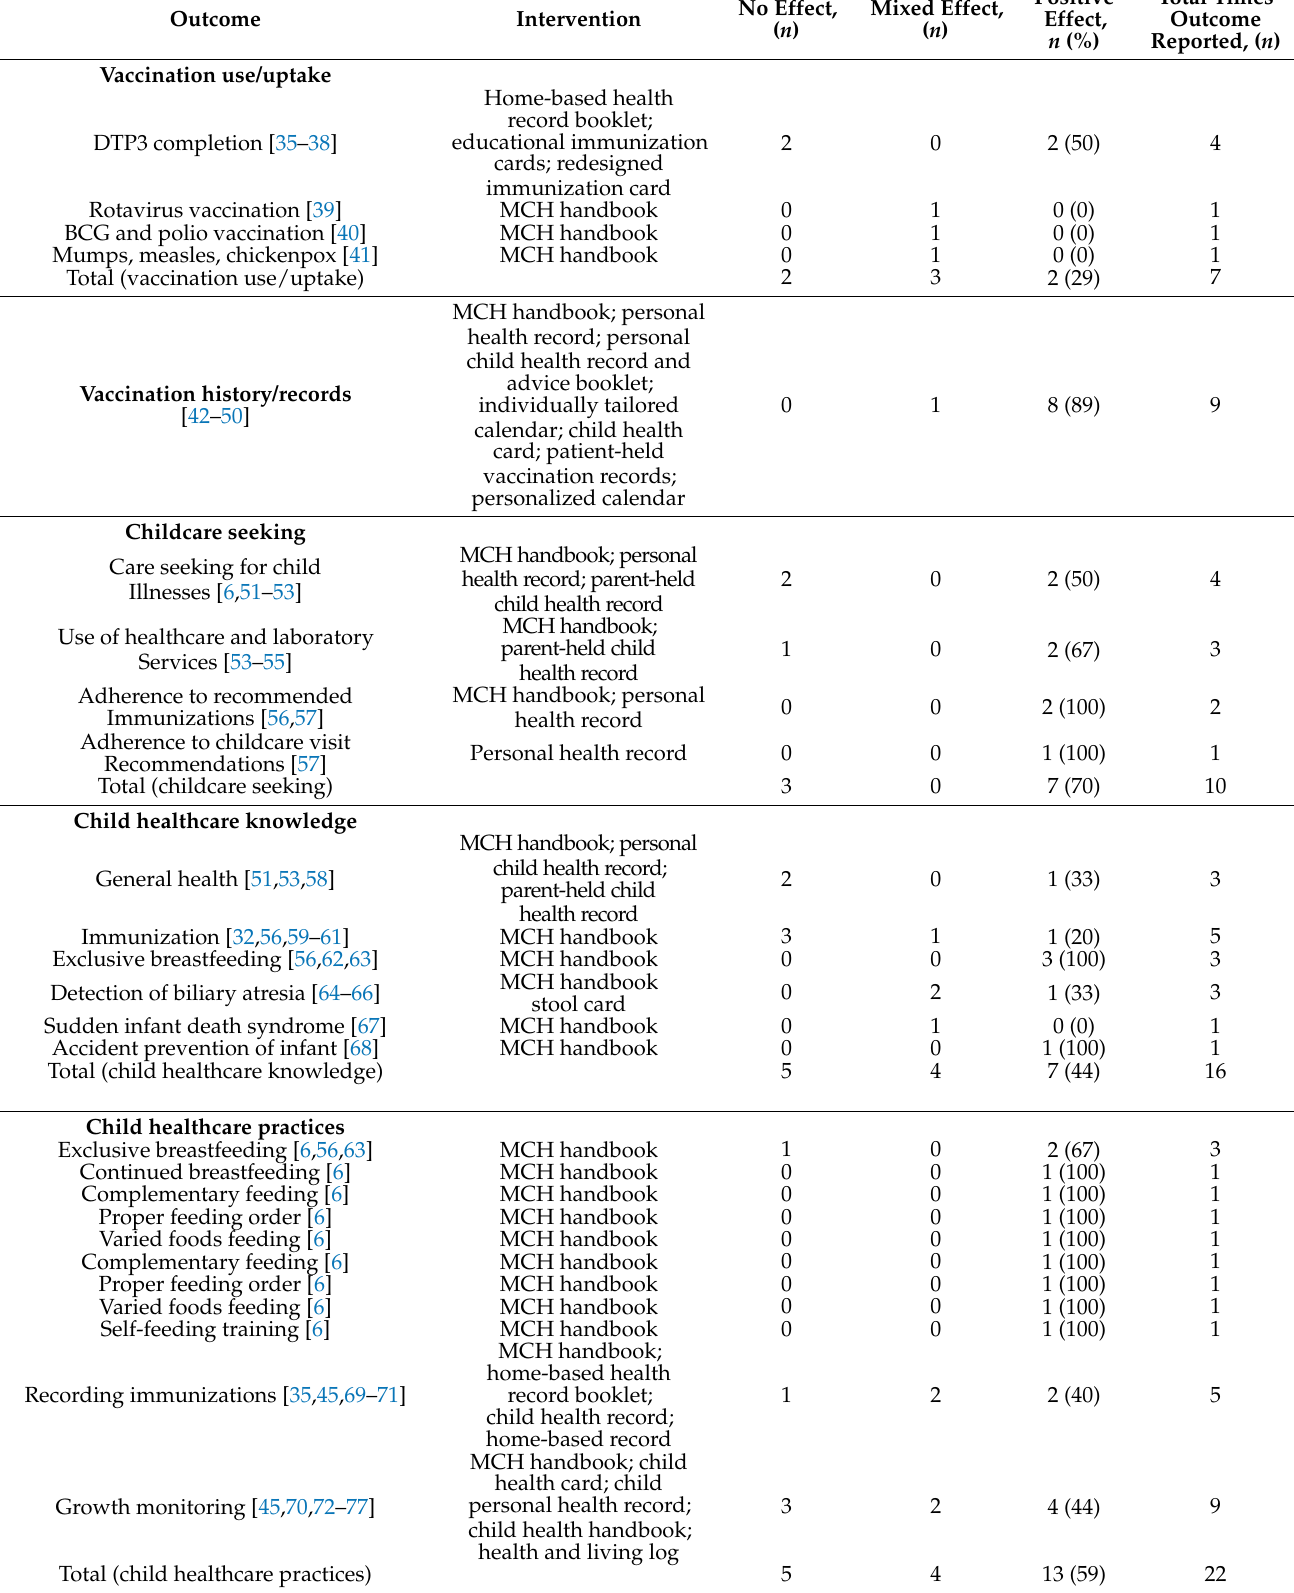
Table 2. Roles of the MCH handbook and other home-based records on child health. Outcome Intervention